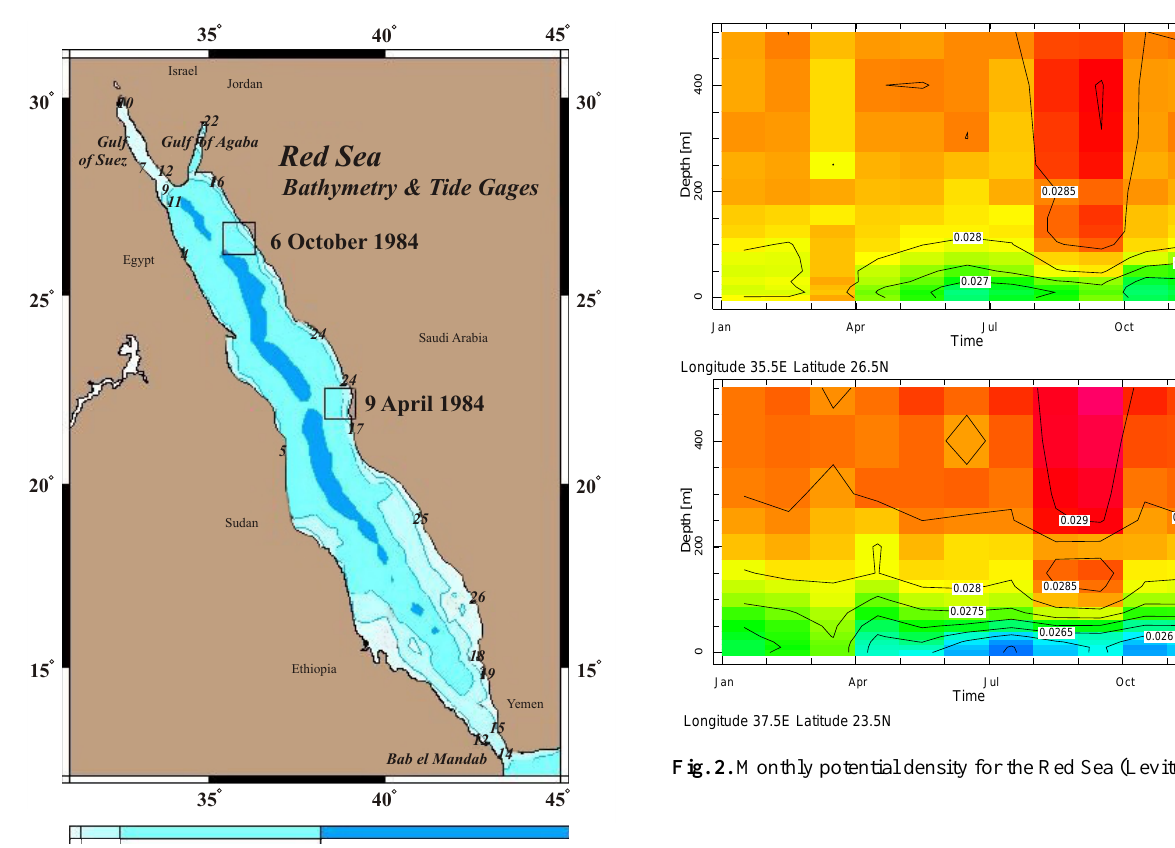
correspond to the “deep” shelf according to our classifica- tion.